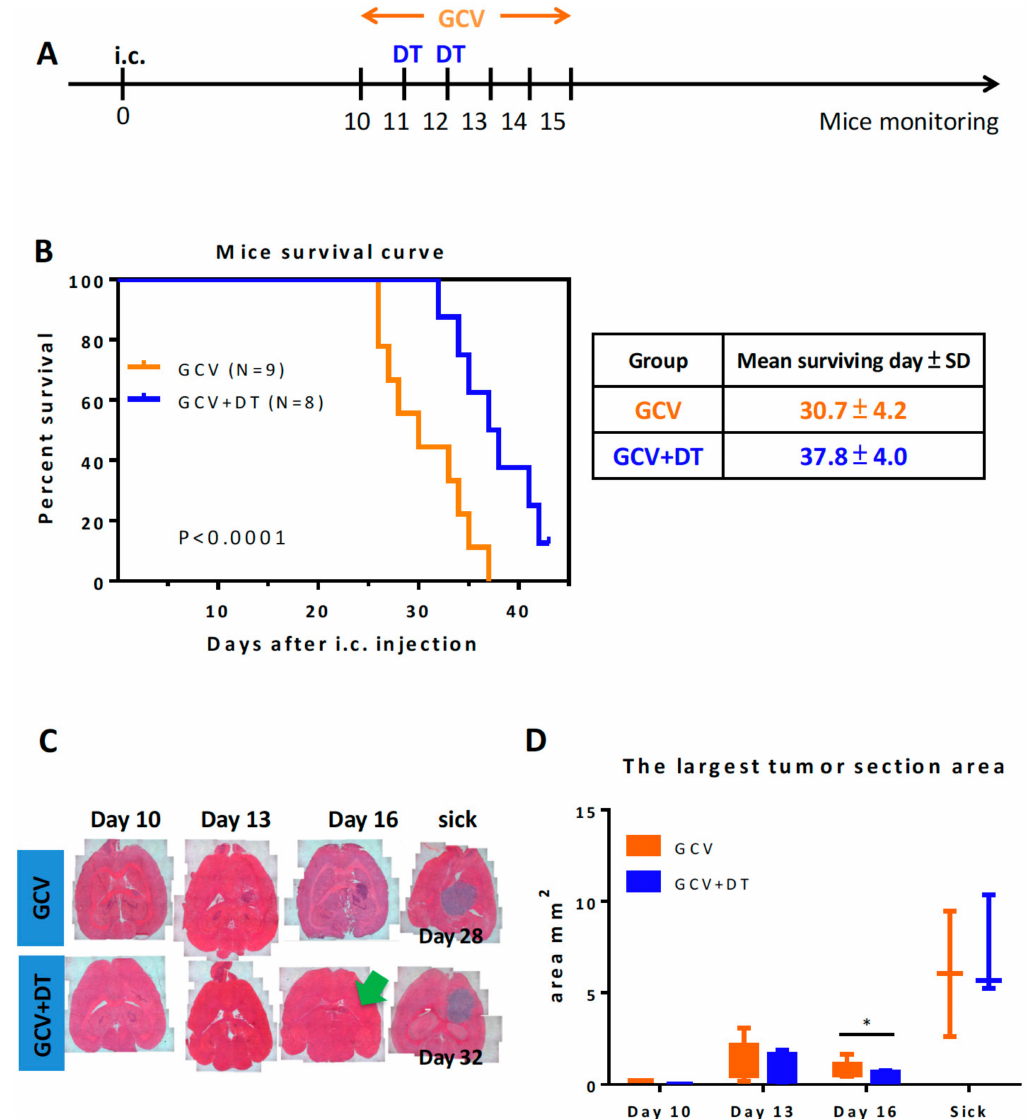
Figure 4. Selective CD11b + Ly6G - Ly6C - MDCs depletion benefits tk / GCV therapy. ( A ) The timeline of in vivo DT and tk / GCV treatment on CD11b-DTR mice-bearing ALTS1C1-tk tumors. ( B ) Kaplan–Meier survival curves of ALTS1C1-tk tumor-bearing mice receiving GCV only or combined DT and GCV treatments (GCV group n = 9, GCV + DT group n = 8), p < 0.0001. ( C ) Representative H&E stained brain tissues at di ff erent time points after tumor inoculation or the time when mice became sick. ( D ) Measurement of the largest tumor section area at di ff erent times after tumor inoculation or when mice became sick ( n ≥ 3 for each group). *, p (0.03) < 0.05 at day